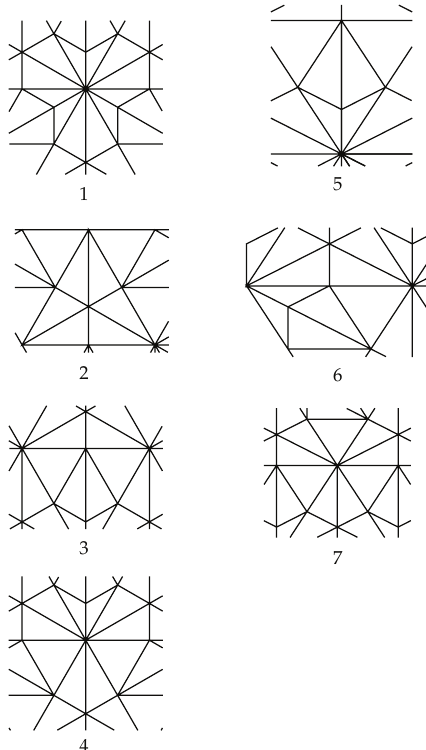
Figure 8: Vertex configurations in T